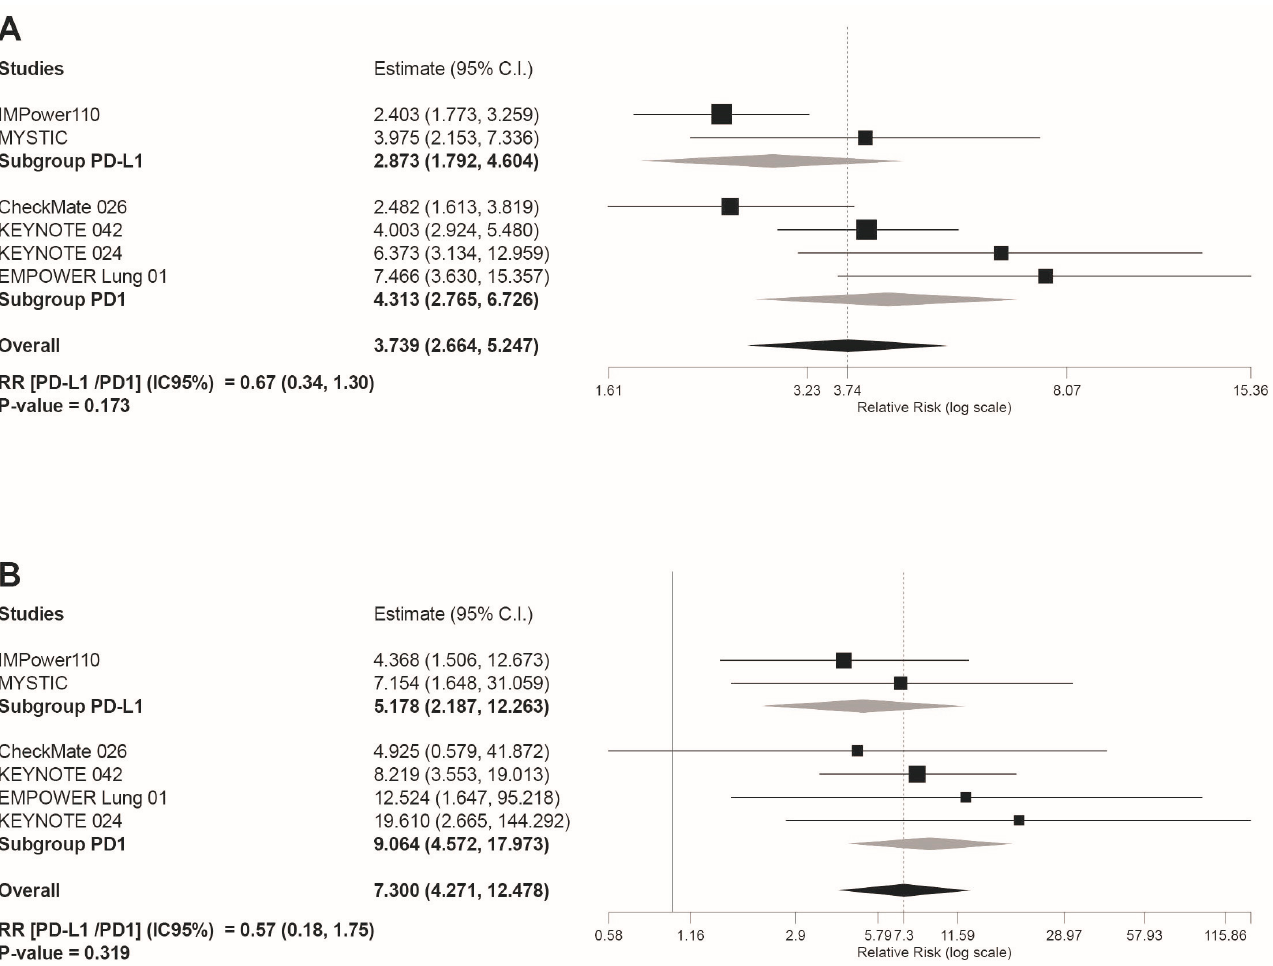
Figure 5. Forest plot of pooled risk ratios (RR)in the subgroup analysis((anti-PD-L1) versus (PD-1 inhibitors)) for: ( A ) any grade irAEs; and ( B ) grade 3–4 irAEs Estimate, RR; CI, confidence interval. RR of ((anti-PD-L1) versus (PD1 inhibitors)) is shown at the bottom left. Treatments are ordered from top to bottom by lower to higher RR. Black squares indicate the weight of each RCT in the MA. The black rhomb indicates the weighted overall immunotherapy RR versus chemotherapy. Grey rhombs indicate, respectively, the weighted RR for anti-PD-1 immunotherapy subgroup compared to chemotherapy, and the weighted RR for anti-PD-L1 immunotherapy subgroup versus chemotherapy. The I 2 index values measuring the heterogeneity of effect-size estimates from the individual studies in MAs A and B correspond respectively to: (I 2 = 68.48%, p = 0.007) and (I 2 = 0%, p =